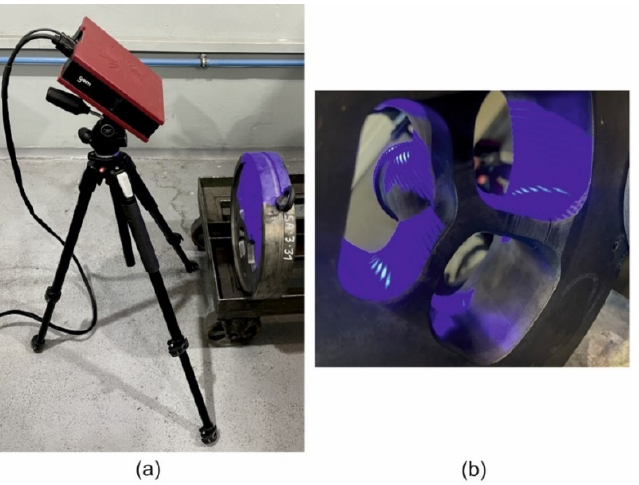
Figure 5. The scanner GOM Atos Core 200 for optical measuring the geometry of extruded tubes and dies a ) and the scanned extrusion porthole die b ).